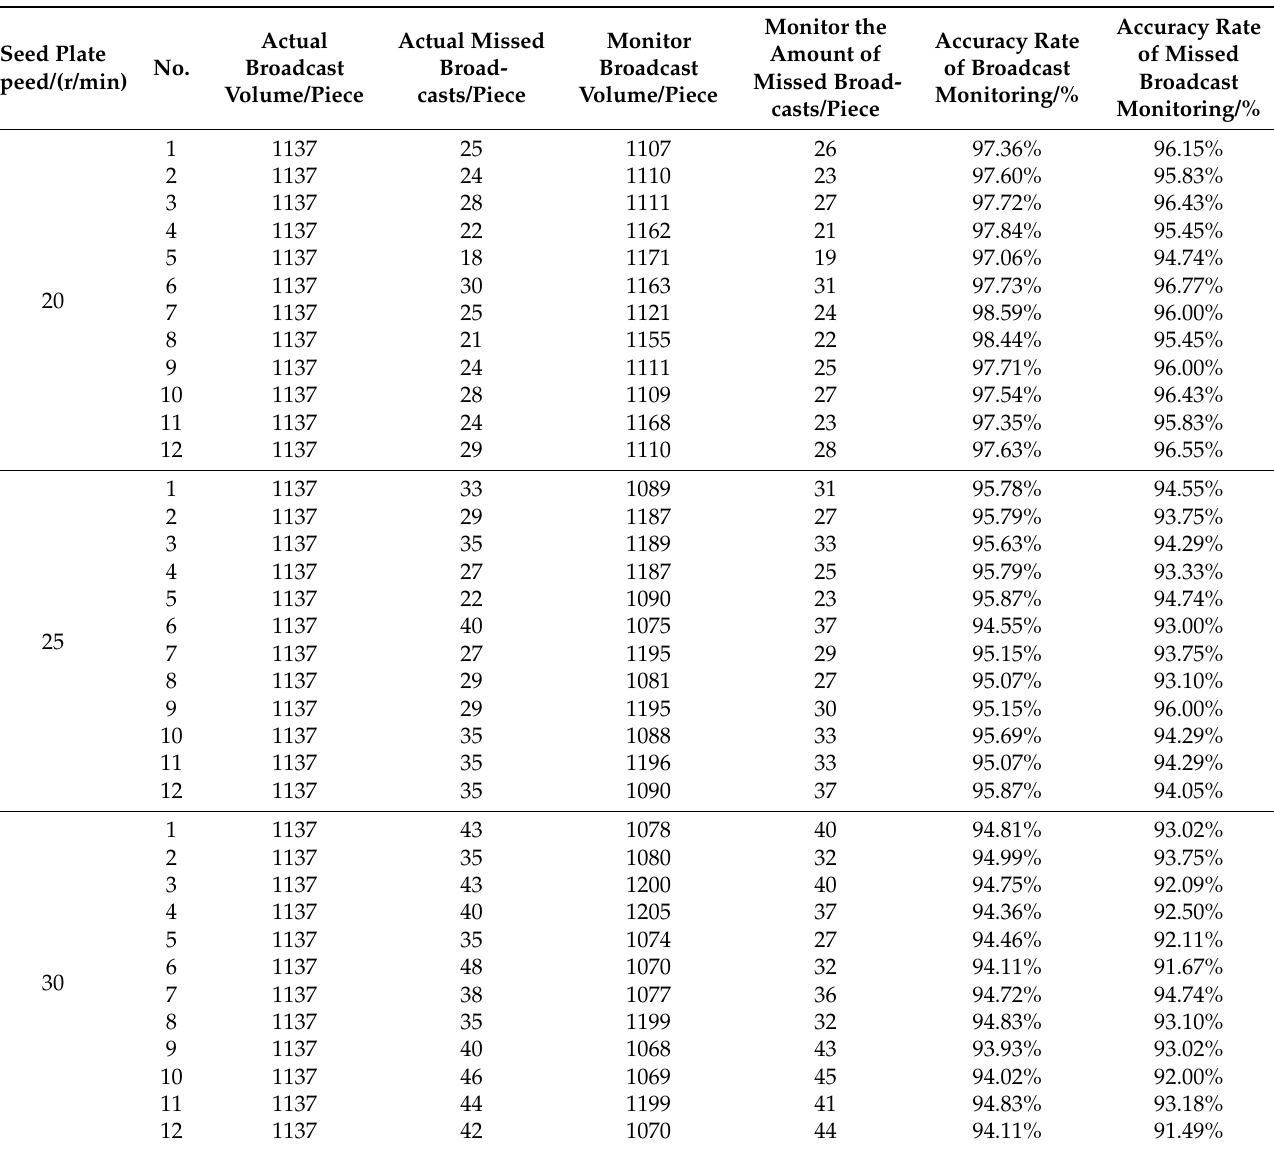
Table 3. Field sowing monitoring test